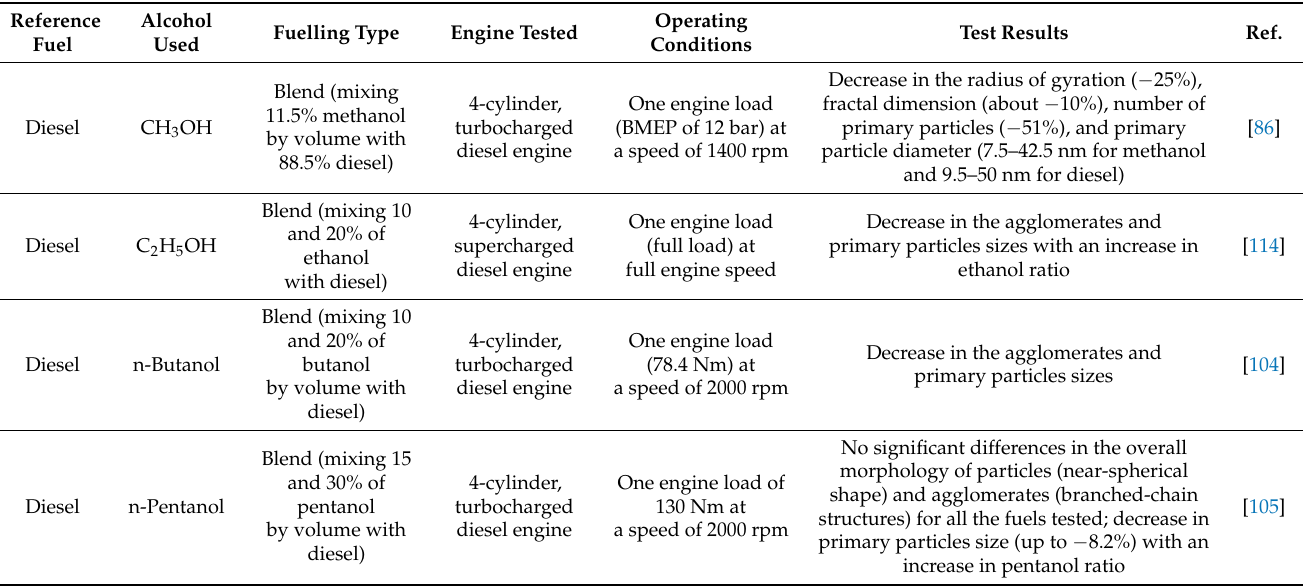
Table 5. Summaty of the reviewed investigations available in the literature about the PM physico- chemical properties of diesel